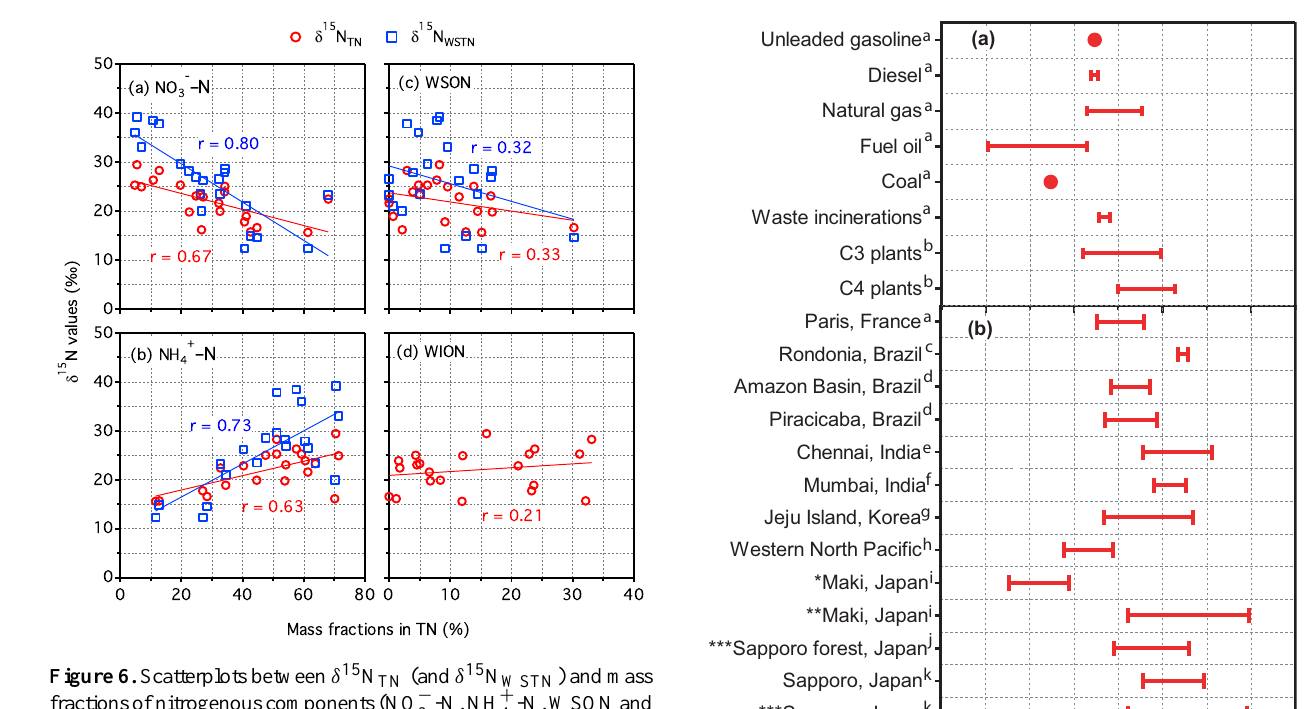
-N, NH + -N, WSON and 3 4